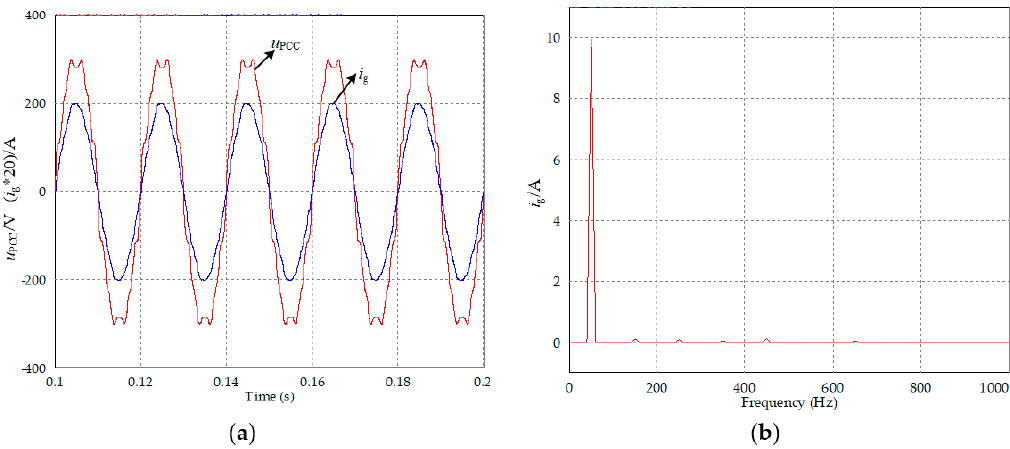
Figure 16. Simulation results of grid voltage feedforward control strategy. ( a ) Waveforms of grid voltage and current. ( b ) FFT analysis of grid current (THD = 3.3%). voltage and current. ( b ) FFT analysis of grid current (THD = 3.3%).